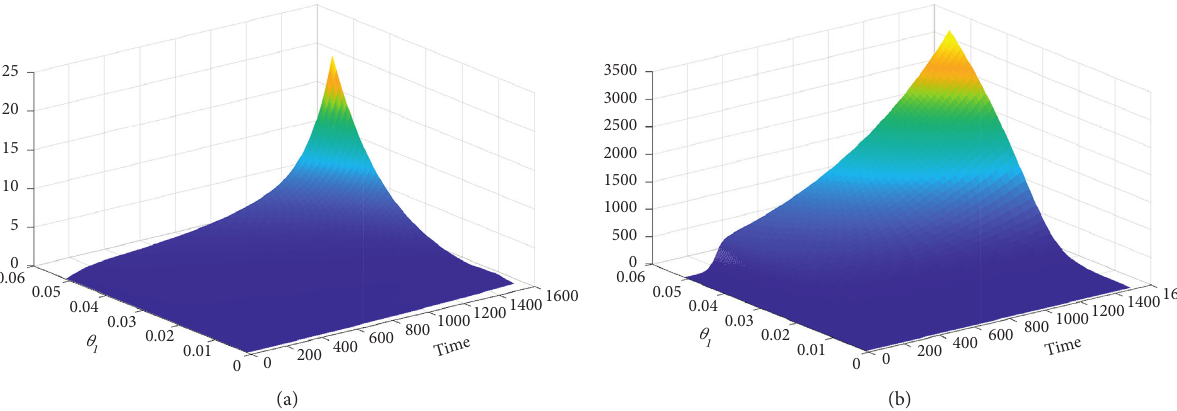
Figure 6: Amount of the information as a function of time and θ controls.